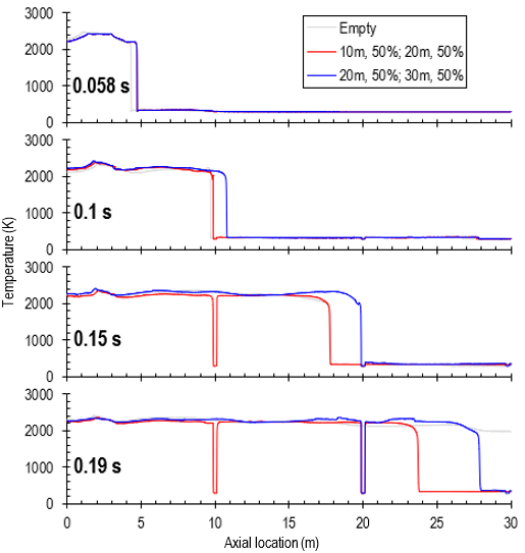
Figure 15. Evolution of temperature profiles along the tube centreline for different scenarios where two obstructions are installed at different locations (at 10 m and 20 m; and at 20 m and 30 m) with 50% inflation. The temperature profiles in the empty tube are also included for